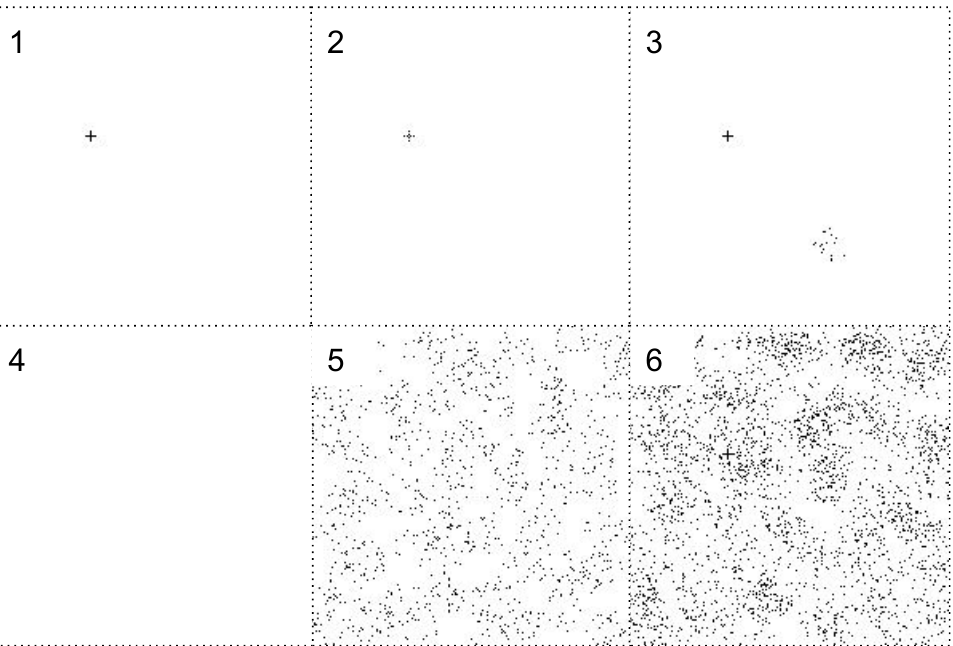
Figure 5. Exemplary fitness values for synthetic images (1: UAV (Unmanned Aerial Vehicle) ground truth Fitness = 4.0; 2: UAV and small noise Fitness = 3.99899; 3: UAV with local small noise cloud Fitness = 3.93210; 4: UAV out of the range Fitness = 3.07090; 5: noise only, UAV out of the range Fitness = 1.39585; and 6: UAV and significant noise Fitness =